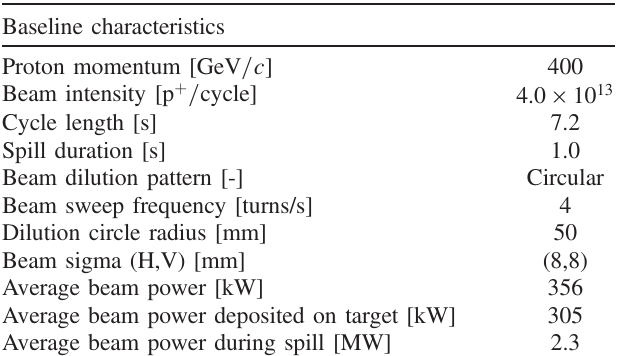
TABLE I. Baseline beam parameters of the BDF target operation. Baseline characteristics